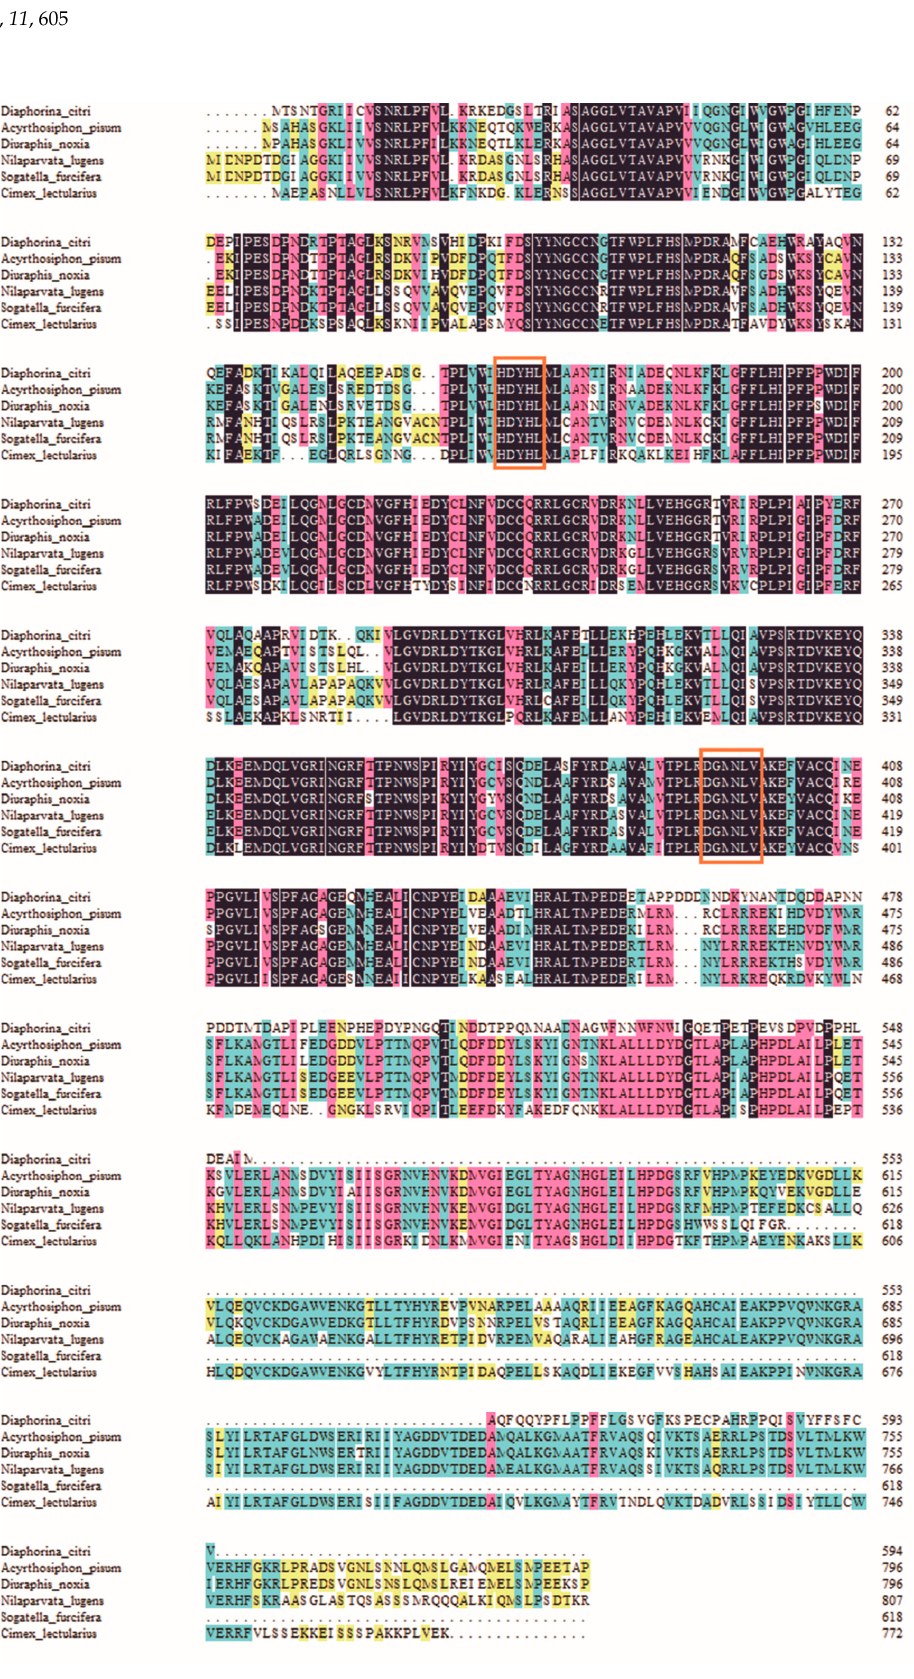
Figure 2. The amino acid alignment of trehalose-6-phosphate synthase (TPS) sequences from Diaphorina citri (MT675285), Acyrthosiphon pisum (XP_001944221), Diuraphis noxia (XP_015365486), Nilaparvata lugens (ACV20871), Sogatella furcifera (JQ013797), Cimex lectularius (XP_014255923). Signature motifs unique to trehalose-6-phosphate synthase (TPS) (HDYHL and DGMNLV) are indicated with red